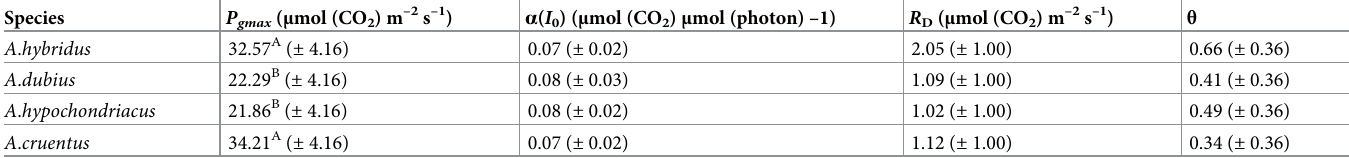
Table 2. Means and confidence intervals (95%) for apparent quantum yield at zero PPFD ( α ( I 0 )), convexity ( θ ), dark respiration rate ( R D ), and the mean compari- son (Tukey honest significant test) of species effect on maximum gross photosynthesis ( P gmax ). Species